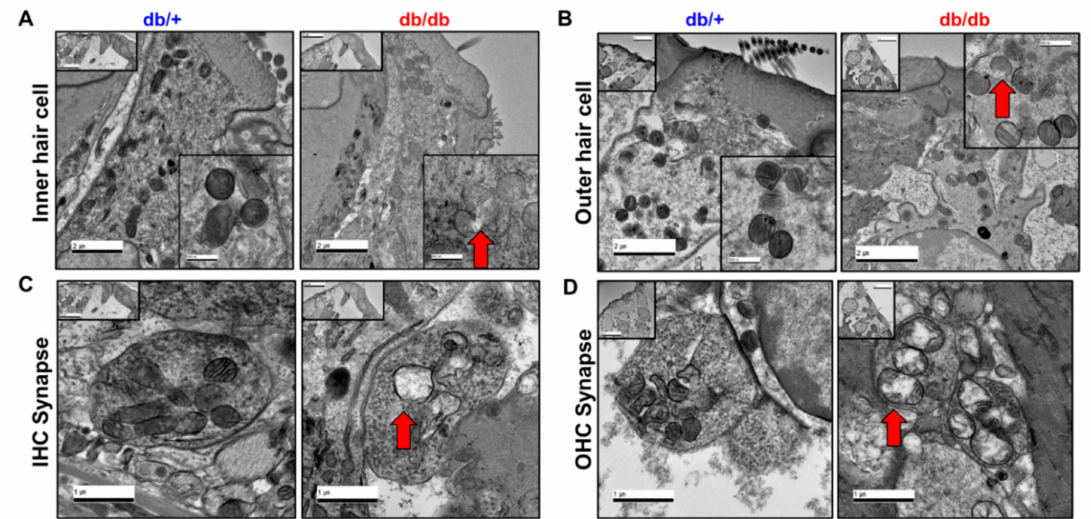
Figure 5. Representative transmission electron microscopy (TEM) images of mitochondria from cochlear IHC, OHC, and synapses. Cochlea mitochondria of diabetic mice were significantly damaged in the inner ( A ) and outer hair cells ( B ) and synapses ( C , D ) compared to wild-type. Mitochondria from diabetic cochlea contain vacuolated mitochondria with disrupted cristae. Scale bars, ( A , B ), 2 µ m, insert, 500 nm; ( C , D ), 1 µ m, insert, 20 µ m.